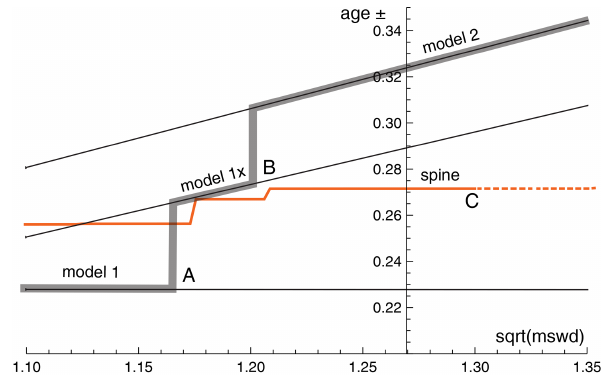
√ mswd under √ mswd .